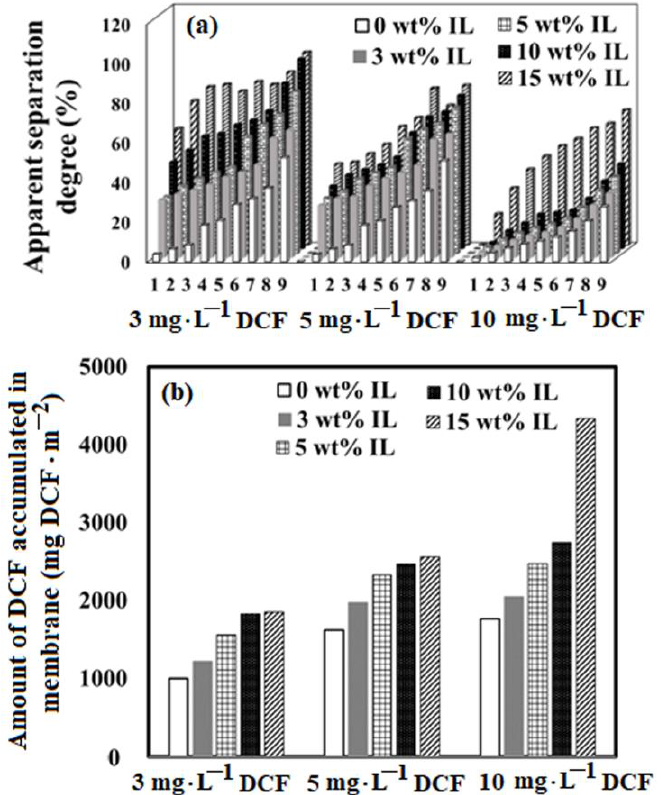
Figure 8. The rejection degree of DCF developed by the studied membranes ( a ) and the amount of DCF accumulated on the membranes at the end of the treatment cycles ( b ) for PSFQ/Aliquat 336 system.